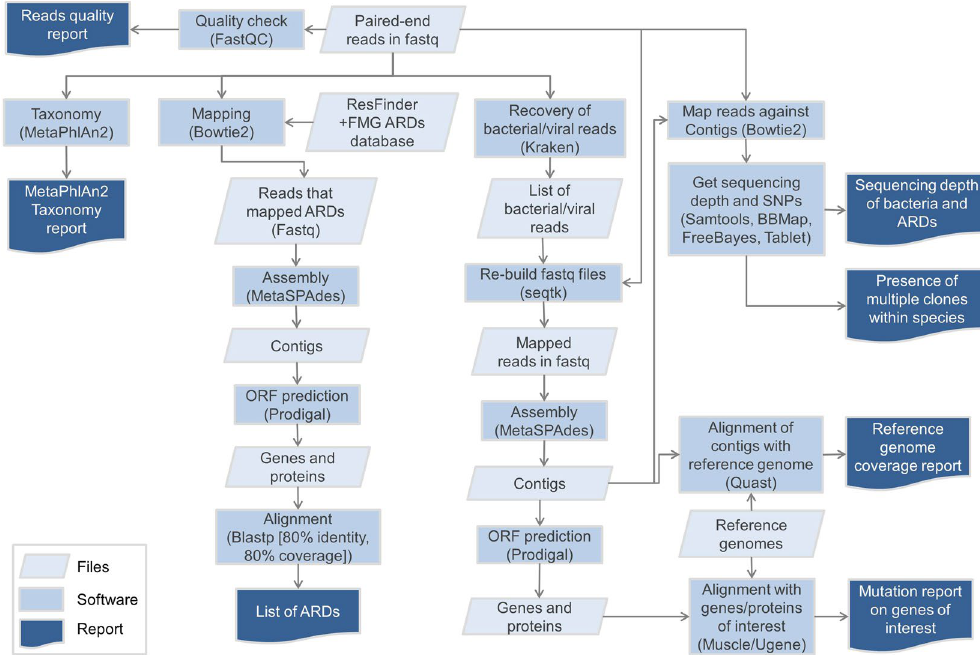
Figure 1. Bioinformatic analysis performed in this study. ARDs: antibiotic resistance determinants. Fastq: format for the files that embeds the read sequences and their per-base quality score. FMG: functional metagenomics; ARDs: antibiotic resistance determinants; ORF: open reading